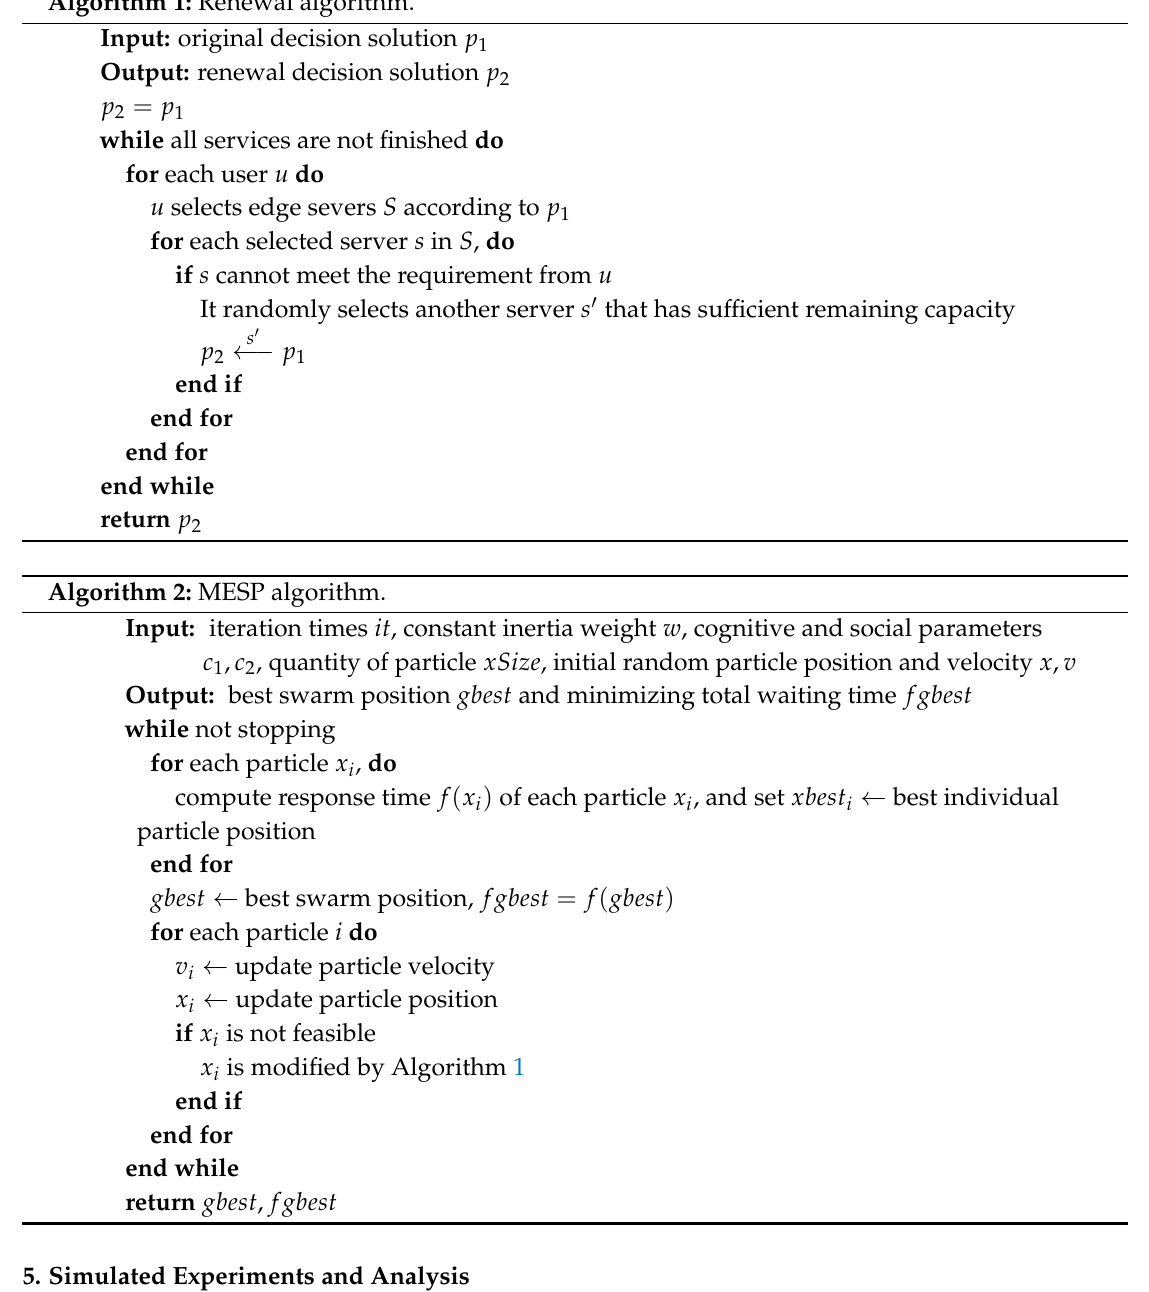
Algorithm 1: Renewal algorithm.